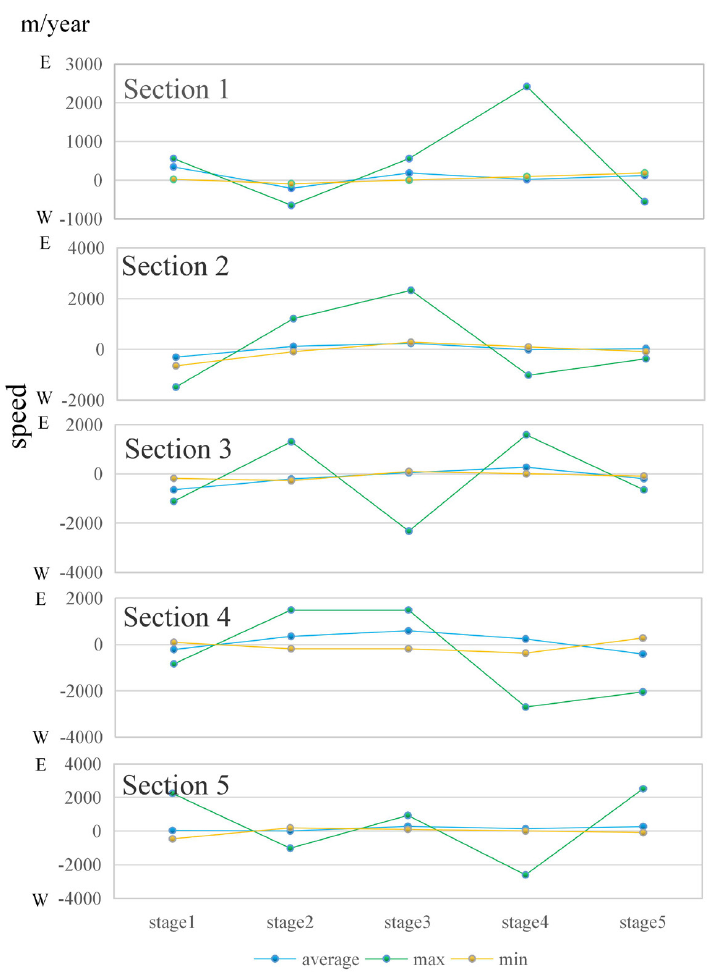
Figure 9. Movement of sand ridge line in typical sections.